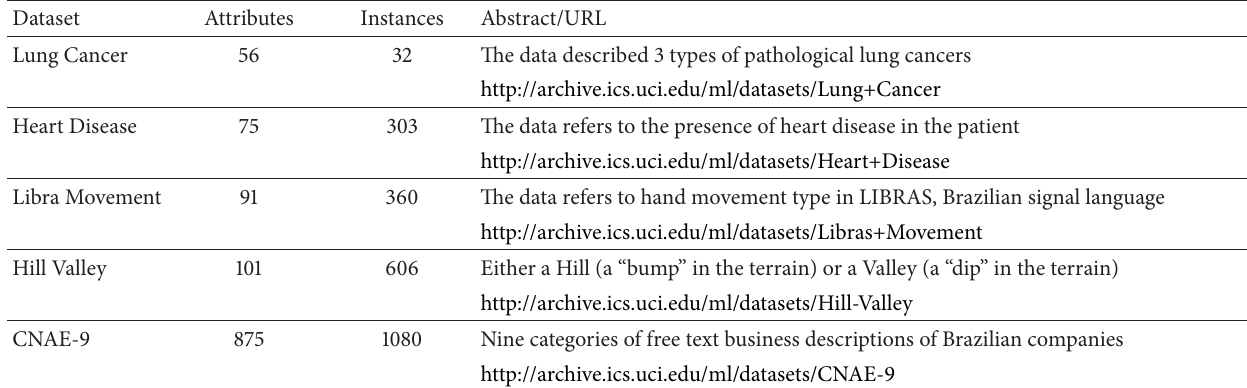
Table 3: Datasets that are used in feature selection